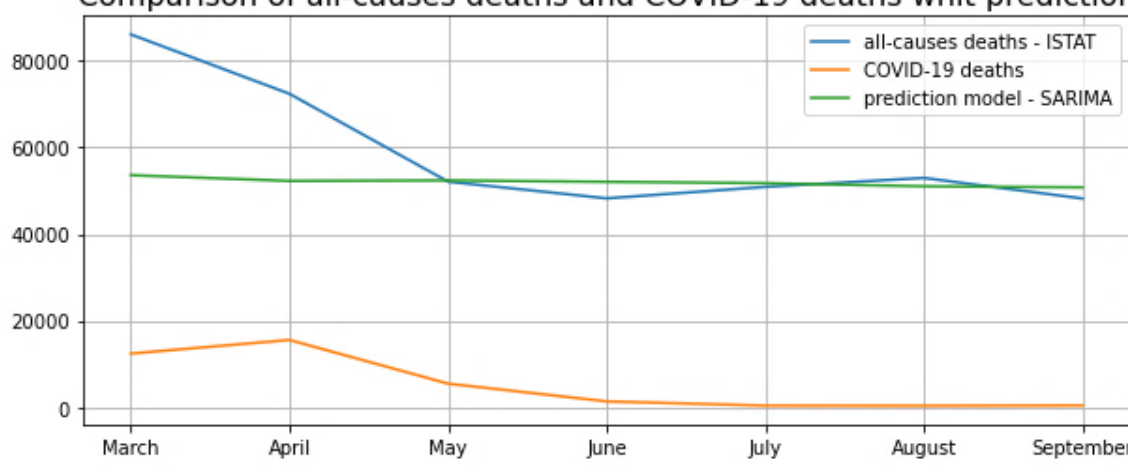
Figure 16. Comparison of expected deaths according to the prediction with deaths recorded in Italy for all causes and for